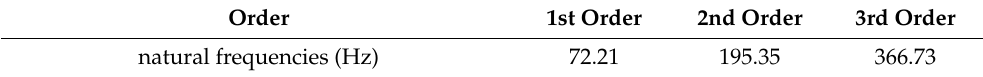
Table 3. The first three-order natural frequencies of the model obtained via simulation calculation.